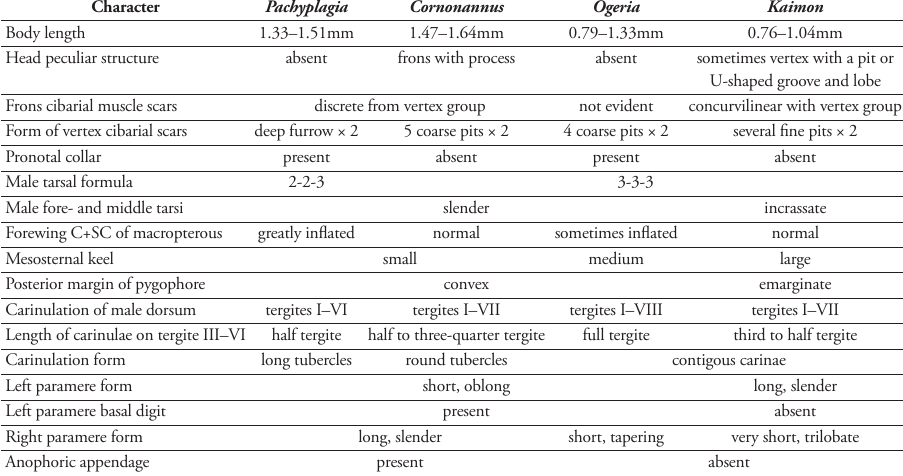
Table 1. Comparision of Cornonannus gen. nov., Ogeria Distant 1913, Pachyplagia Gross, 1951, and Kaimon Hill, 2004 (partly modified from Hill